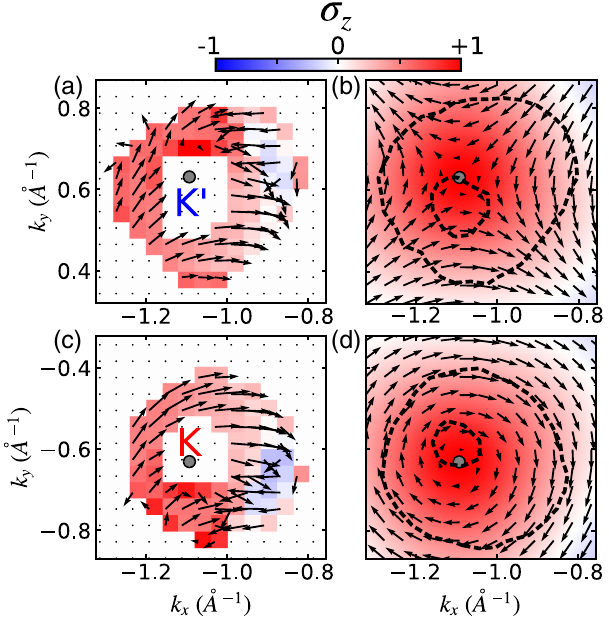
FIG. 6. Reconstruction of orbital pseudospin. (a,b) Pseudospin texture reconstructed from experimental (with emulated CDAD) data. The in-plane pseudospin is represented by the arrows, while the z component is indicated by the color map. We present results − 0 . 25 eV, where the reconstruction procedure for E − E VBM ¼ is most stable. (c,d) Orbital pseudospin from the TB model. The black dashed lines indicate the region in which the intensity I E; k Þ > 0 . 1 I ( I is the maximum av ð max max